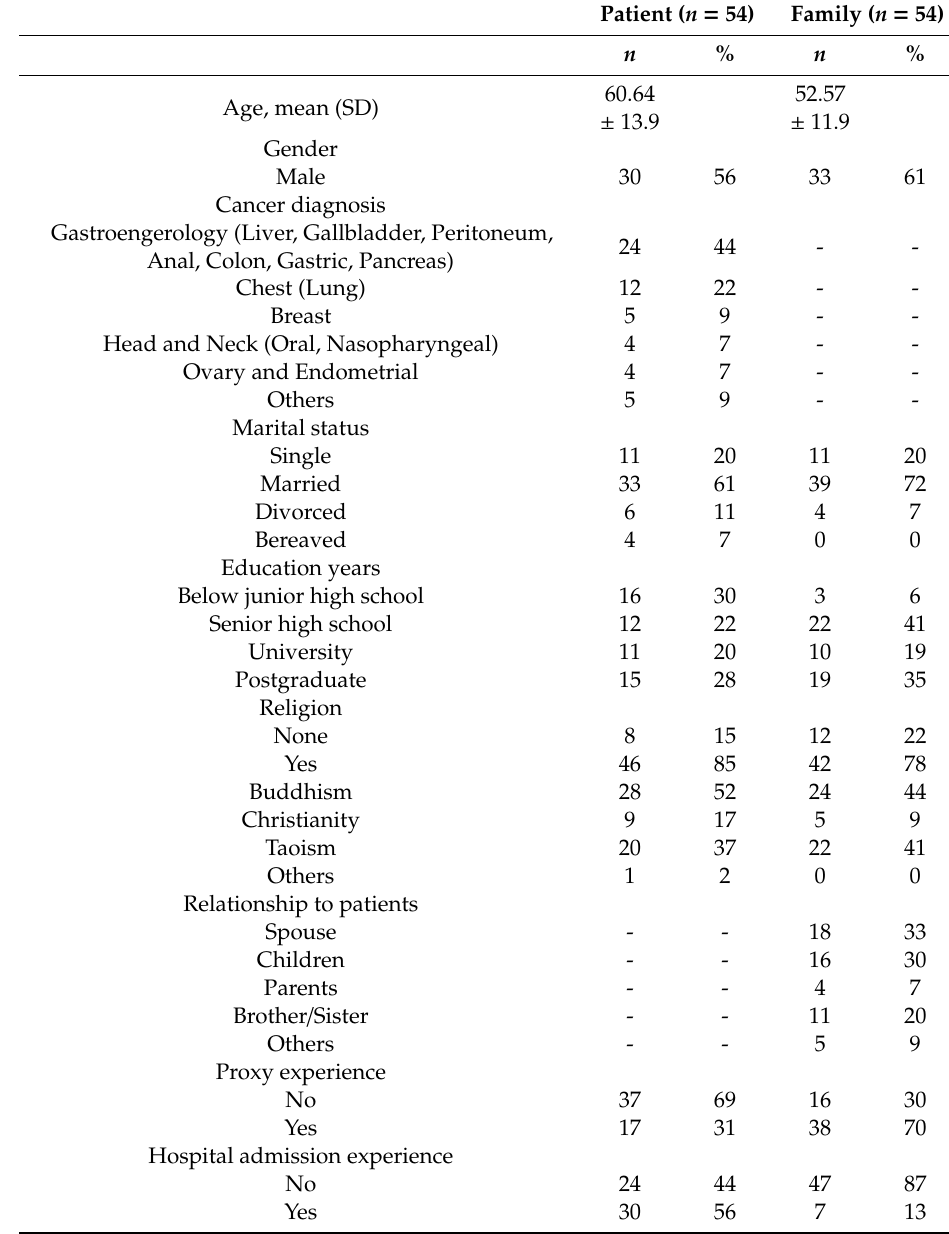
Table 1. Demographics and clinical characteristics of patients and family